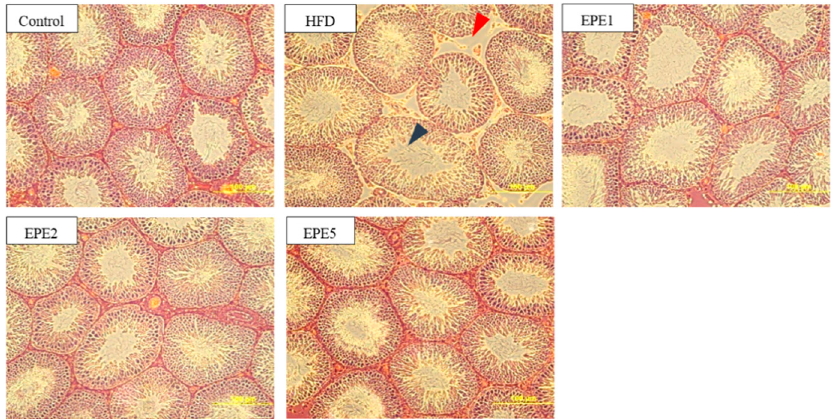
Figure 10. Effects of Echinacea purpurea ethanol extract on seminiferous tubules in HFD-induced obese rats. obese